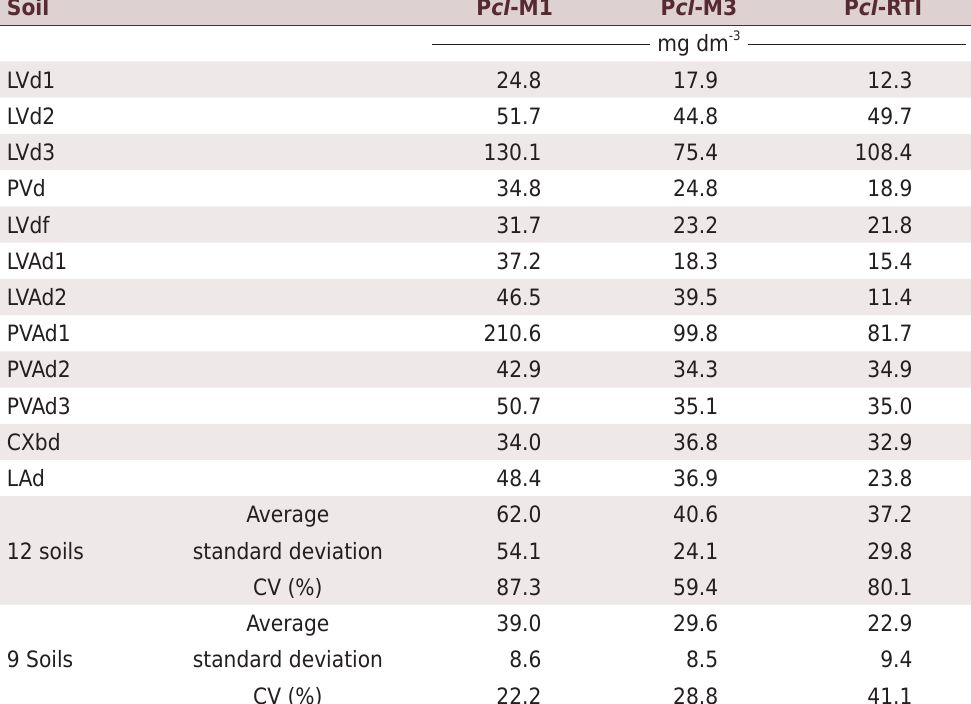
Table 5. Soil P critical level by Mehlich-1 (P cl -M1), Mehlich-3 (P cl -M3), and Ion Exchange Resin (P cl -RTI); average, standard deviation, and coefficient of variation (CV) of P critical level (P cl ) obtained by each extractant with 12 soils, and 9 soils (after removing the soils LVd1, LVd2, and PVAd1)